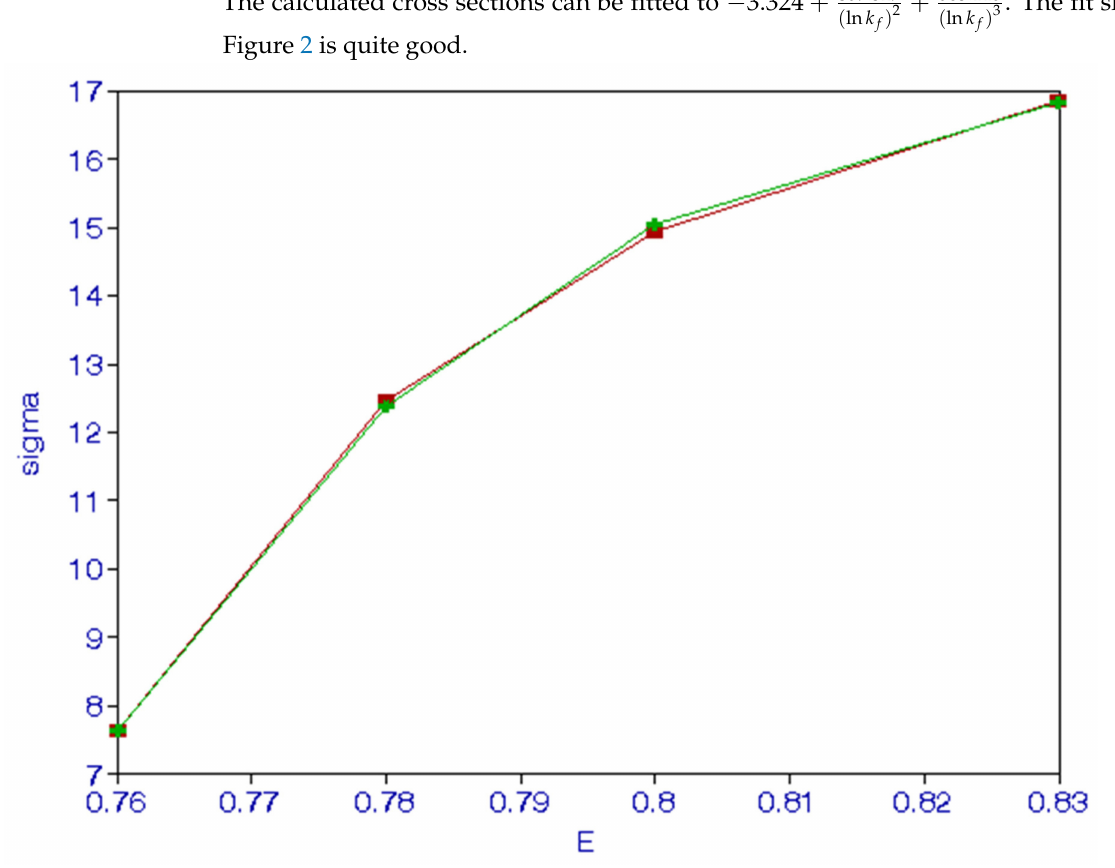
) vs. the incident 0